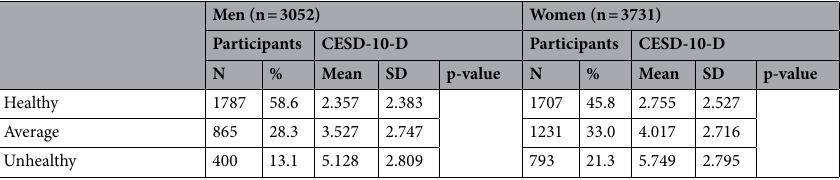
Table 1. Baseline characteristics of the study population according to the short-form Center for Epidemiologic Studies Depression Scale (CESD-10-D) scores. Underweight: BMI < 18.5; normal weight: 18.5 ≤ BMI < 23; overweight: 23 ≤ BMI < 25; obesity: 25 ≤ BMI < 30; severe obesity: 30 ≤ BMI. BMI body mass index, SD standard deviation, CESD-10-D Shorter form of the Center for Epidemiologic Studies Depression